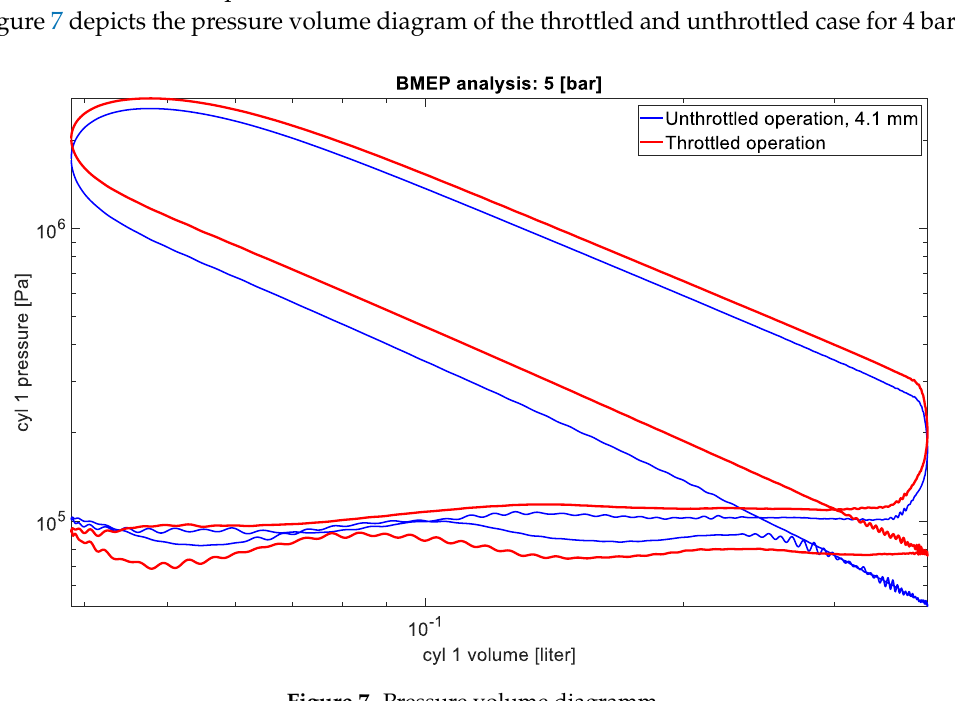
Figure 7. pressure volume diagramm . Figure 7. Pressure volume